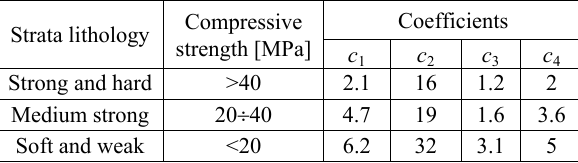
Table 4. Coefficients for average height of caved zone and fractured zone